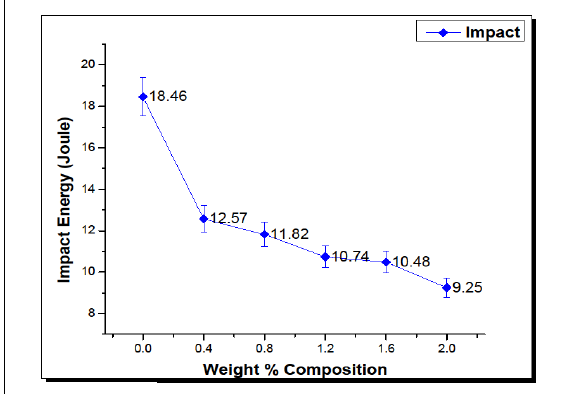
Figure 9: Tensile Stress against Tensile strain of the graphite nano-particulate reinforced brass composites. Source: Authors, (2022).